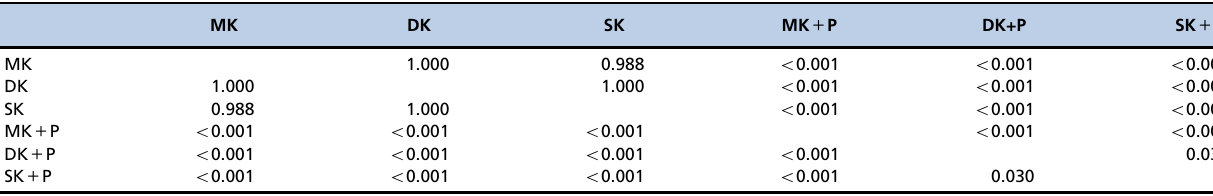
Table 2 - p -values for 2-mm Gap Loads of the six suture